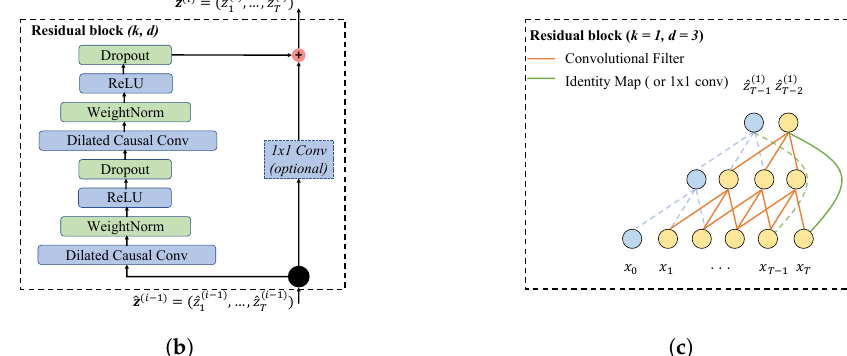
Figure 5. Structure of proposed temporal convolutional networks. ( a ) Residual learning block; ( b ) TCN residual block; ( c ) example of residual connection in a